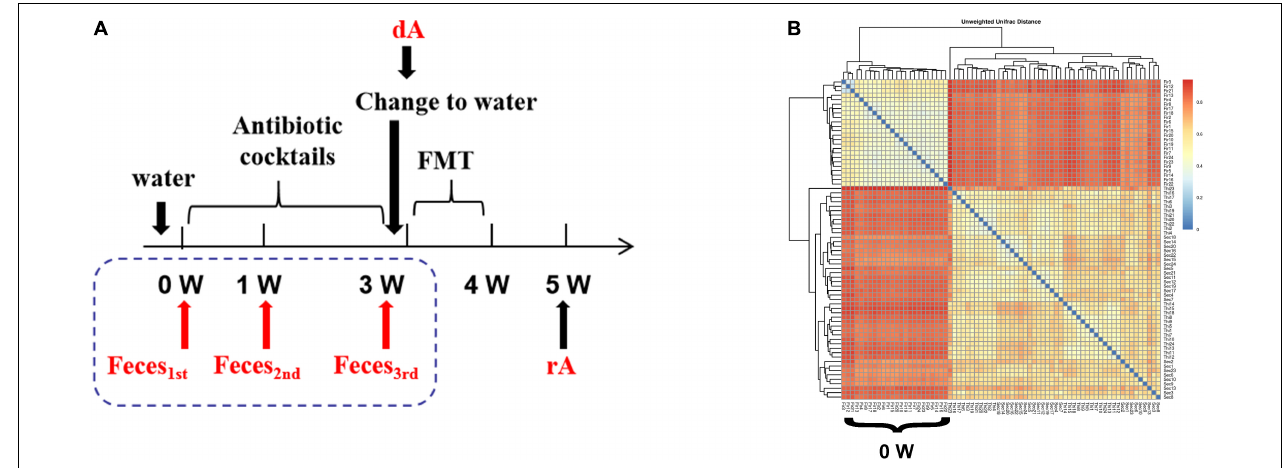
FIGURE 1 | The cluster of fecal microbiota. (A) Experimental design drawing. Receptor mice had free access to antibiotic cocktails containing vancomycin (0.5 g/L), ampicillin (1 g/L), neomycin (1 g/L), and metronidazole (1 g/L) in drinking water. Feces were collected on the first day of the experiment (0 W), the first week of the experiment (1 W), the third week of the experiment (3W), as well as feces from donor mice (dM) fed with normal diet and feces from receptor mice (rM) when FMT ended over another 1 week. All mice were fed a normal diet. (B) β -diversity indices of unweighted_unifrac_distance. The redder color is, the farther distance is. dM, donor mice fed with a normal diet; FMT, fecal microbiota transplantation; PLS-DA, partial least squares discriminant analysis; rM, receptor mice transplanted with microbiota from dM.